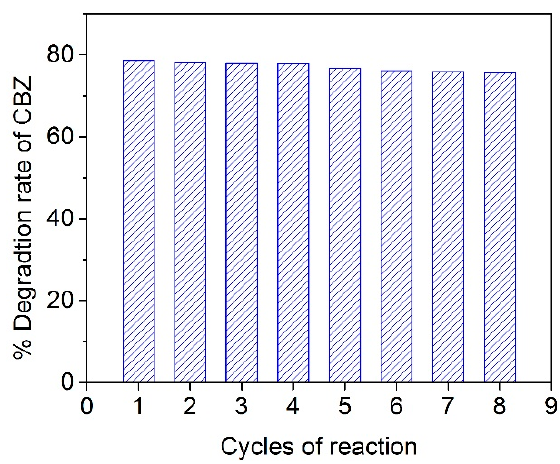
Figure 3. CBZ degradation in repeated experiments with the same BiOBr particles. BiOBr dose 0.5 g · L − 1 , [CBZ] 0 = 5 µ M, [PMS] 0 = 1.0 mM for all cycles, pH = 7.0, T = 24 ◦ C, reaction for 30 min.